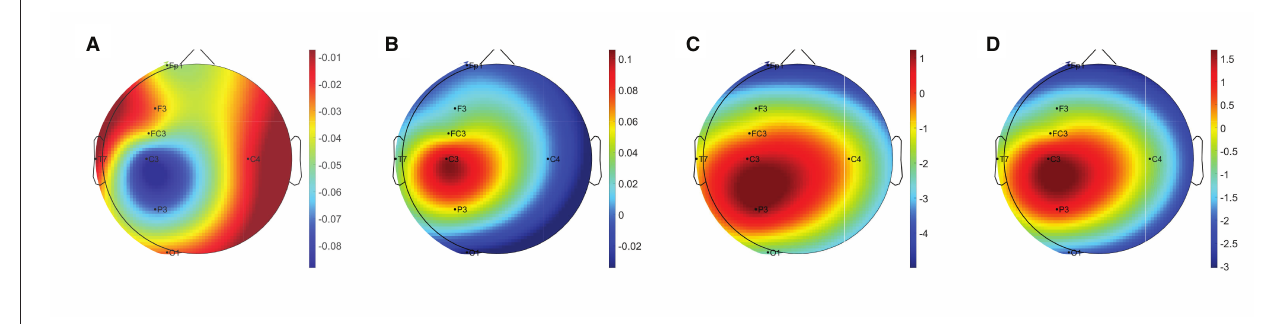
FIGURE 7 | Brain topographies for the difference between recovery and baseline states (i.e., difference = recovery - baseline) of (A) δ relative , (B) α relative , (C) ( θ + α ) /β , and (D) α/β for one participant following the gross motor interaction with HapticMASTER. In each brain map, the nose is represented by the triangle on the top, and the right hemisphere is on the right. For α relative , ( θ + α ) /β , and α/β , the red-shaded areas indicate a larger increase whereas the blue-shaded areas indicate a decrease. For δ relative , the blue-shaded areas indicate a larger decrease whereas the red-shaded areas indicate a smaller decrease.